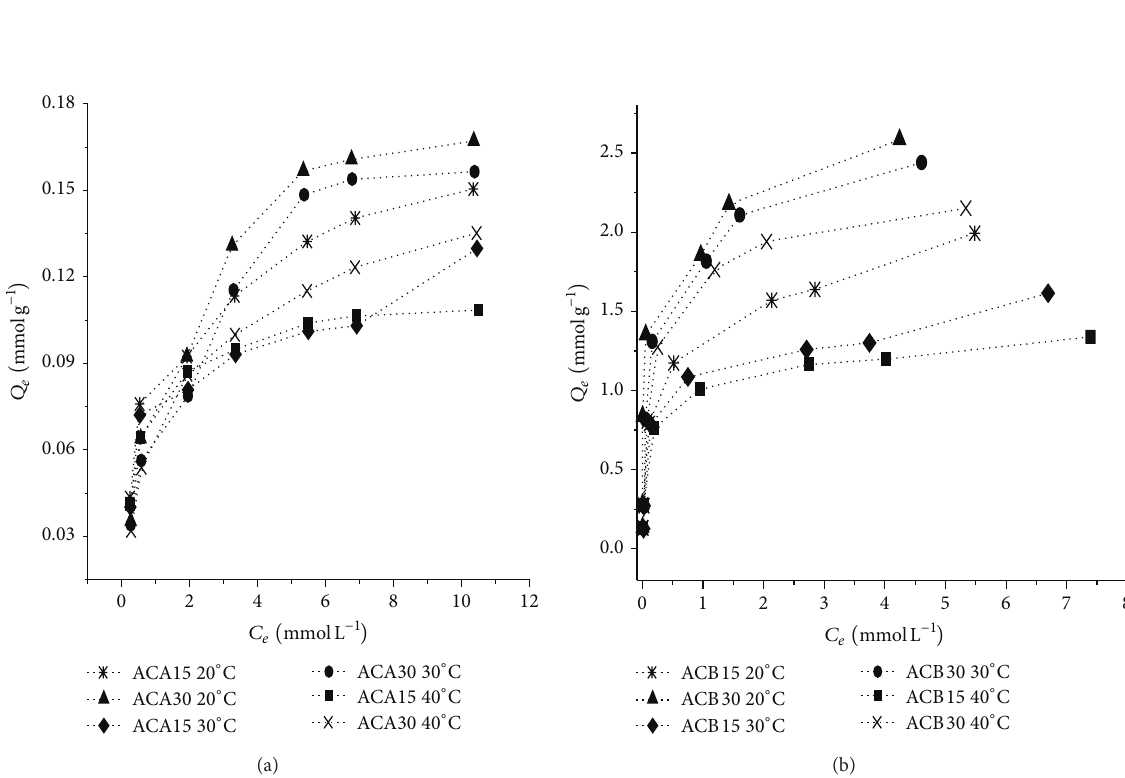
Figure 3: Adsorption isotherms of 4-nitrophenol on